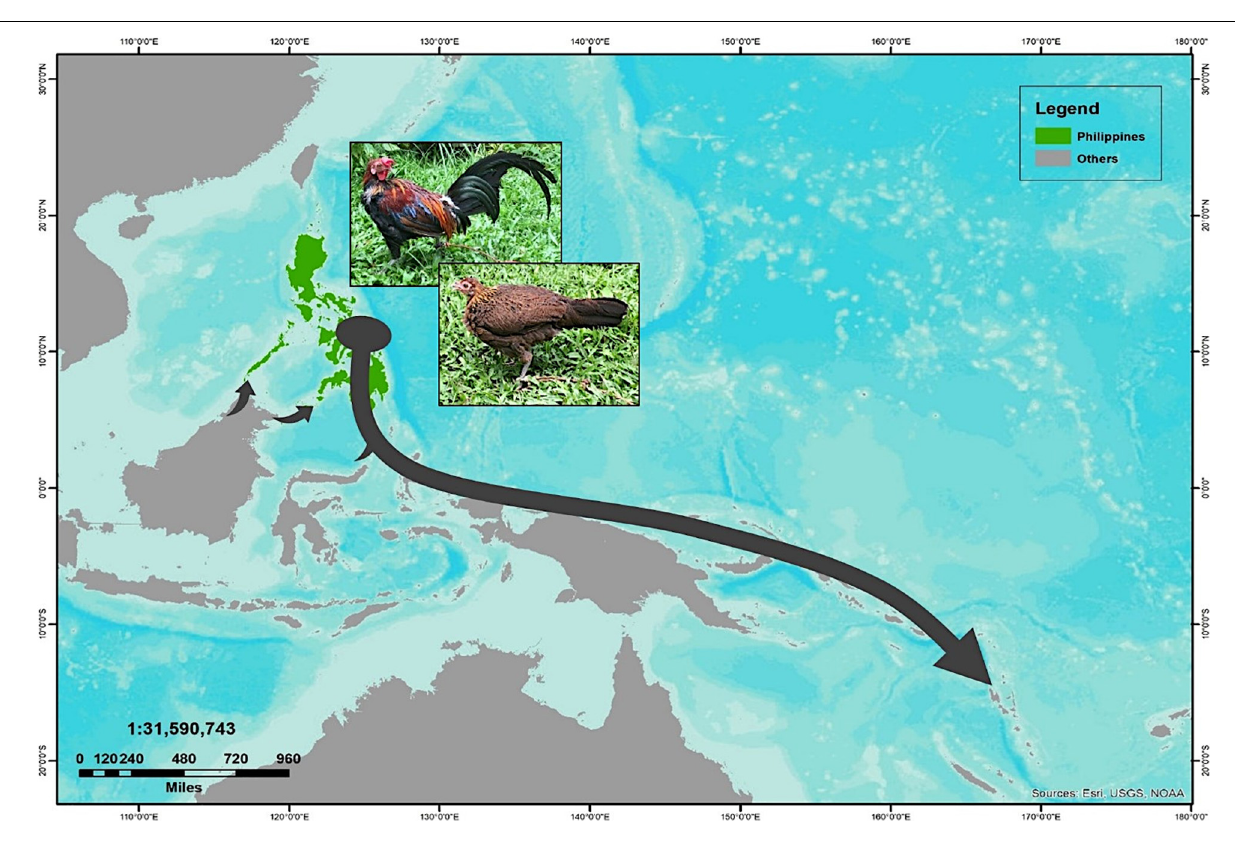
FIGURE 5 | The proposed routes of translocation scenario of Philippine chickens expanding to the Pacific relating to the Austronesian speakers movement, as supported by the population pairwise genetic divergence ( F ST ) estimates, mismatch distribution analyses, and demographic inference based on coalescent simulation of Bayesian skyline plot